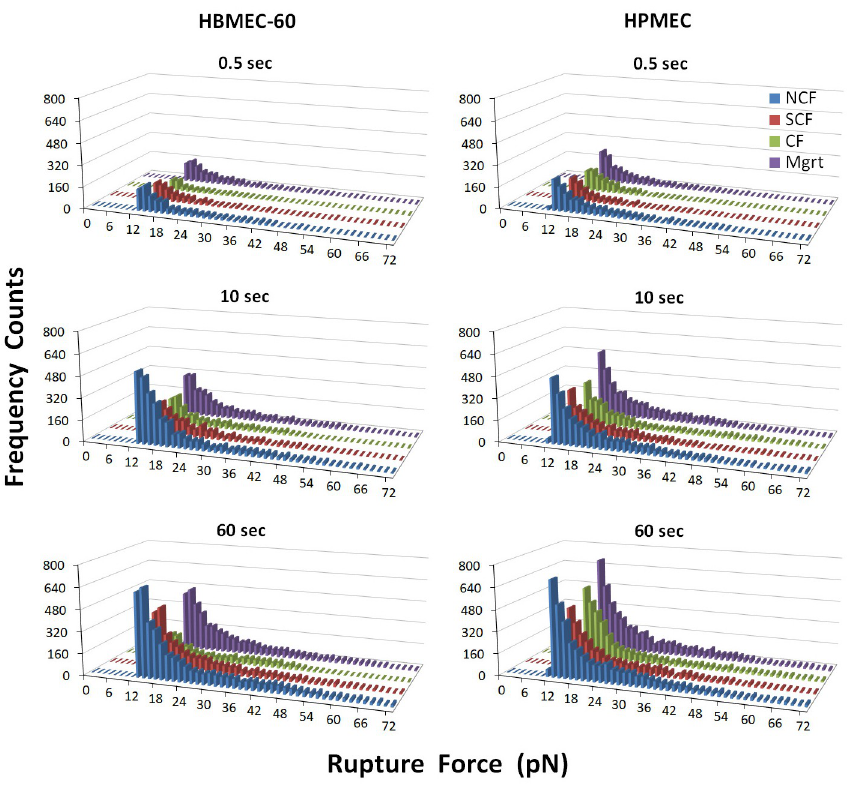
Fig 8. Distributions of rupture forces from MB231/HBME-60 and MB231/HPMEC adhesion measurements in four EC growing states. For all three contact periods, the number of rupture forces were the greatest in NCF HBMEC- 60 cells (1097, 3293 and 4669 counts for 0.5, 10 and 60 sec, respectively), reduced in the SCF cells, and lowest (2.59, 2.58 and 3.35 times less than those in NCF cells) in CF HBMEC-60 cells. Counts of rupture forces in Mgrt HBMEC-60 were slightly lower than those in the NCF cells, but higher than in the SCF cells. In HPMEC, the NCF cells for three contact times demonstrated the largest frequency counts (1423, 3108 and 4519 for 0.5, 10 and 60 sec, respectively) in four growing states. Mgrt cells showed very close counts to NCF cells. In each panel, Frequency Counts are plotted on Y axis and Rupture Forces (pN) on X axis.